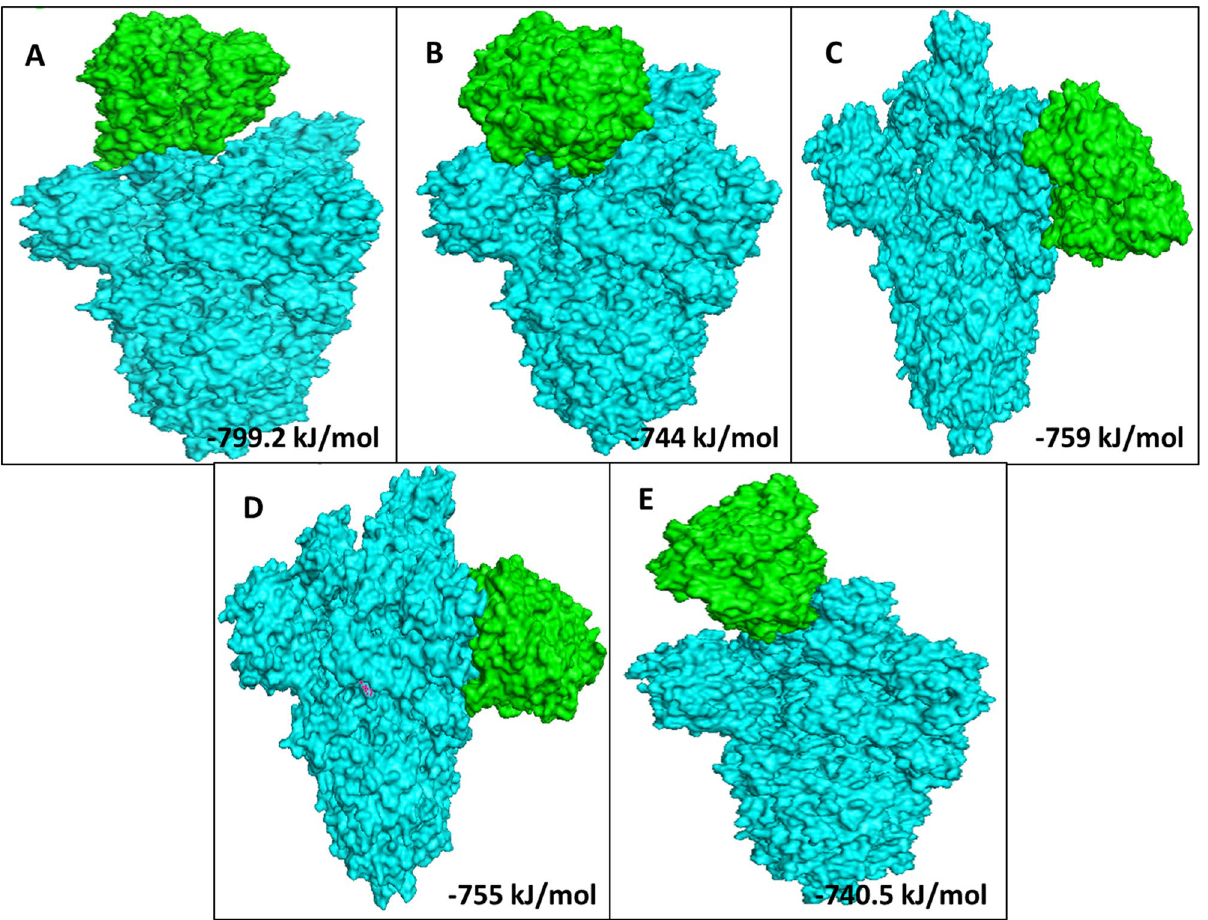
Figure 4. The top 5 docked models displaying interaction of S Protein with ACE2 receptor in the presence of catechin.